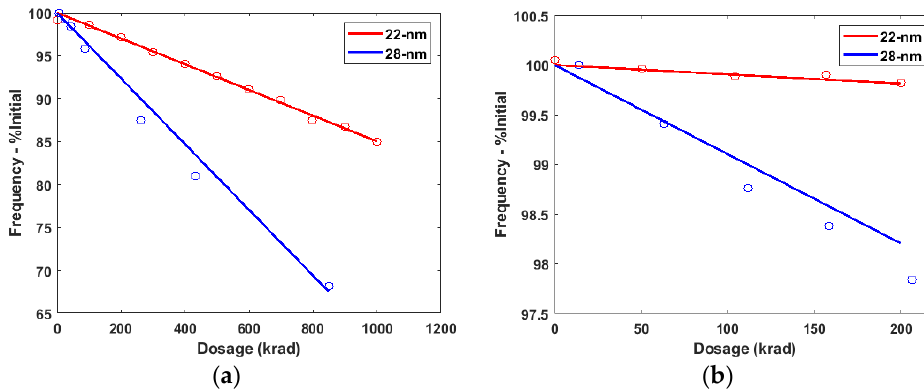
Figure 10. RO frequencies from 22-nm and 28-nm test for ( a ) Co-60 test; ( b ) heavy ion test.